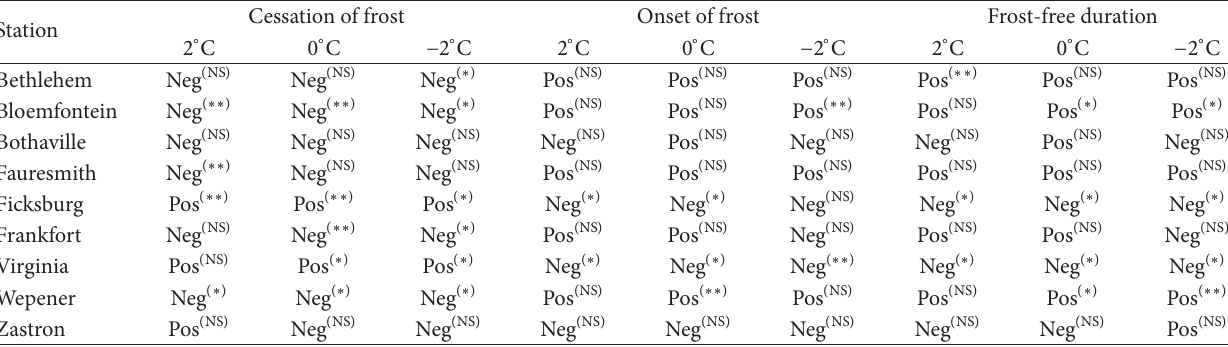
Table 6: Trends in frost indices for Free State province of South